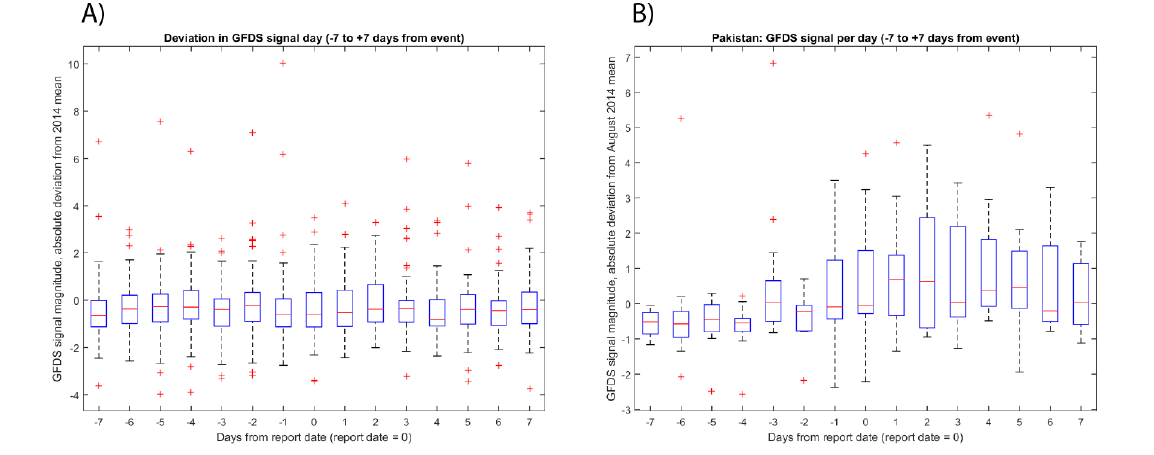
Figure 4. Box plots showing the distribution of signal deviation from the mean, for ( A ) all 80 flood events ( i.e. , 80 locations) reported throughout 2014 in the Philippines; and ( B ) the September 2014 floods in Pakistan at 17 locations. For the event date (“day 0” on x-axis), we used the specific reported event date for each individual event for the Philippines; and 4 September 2014 for